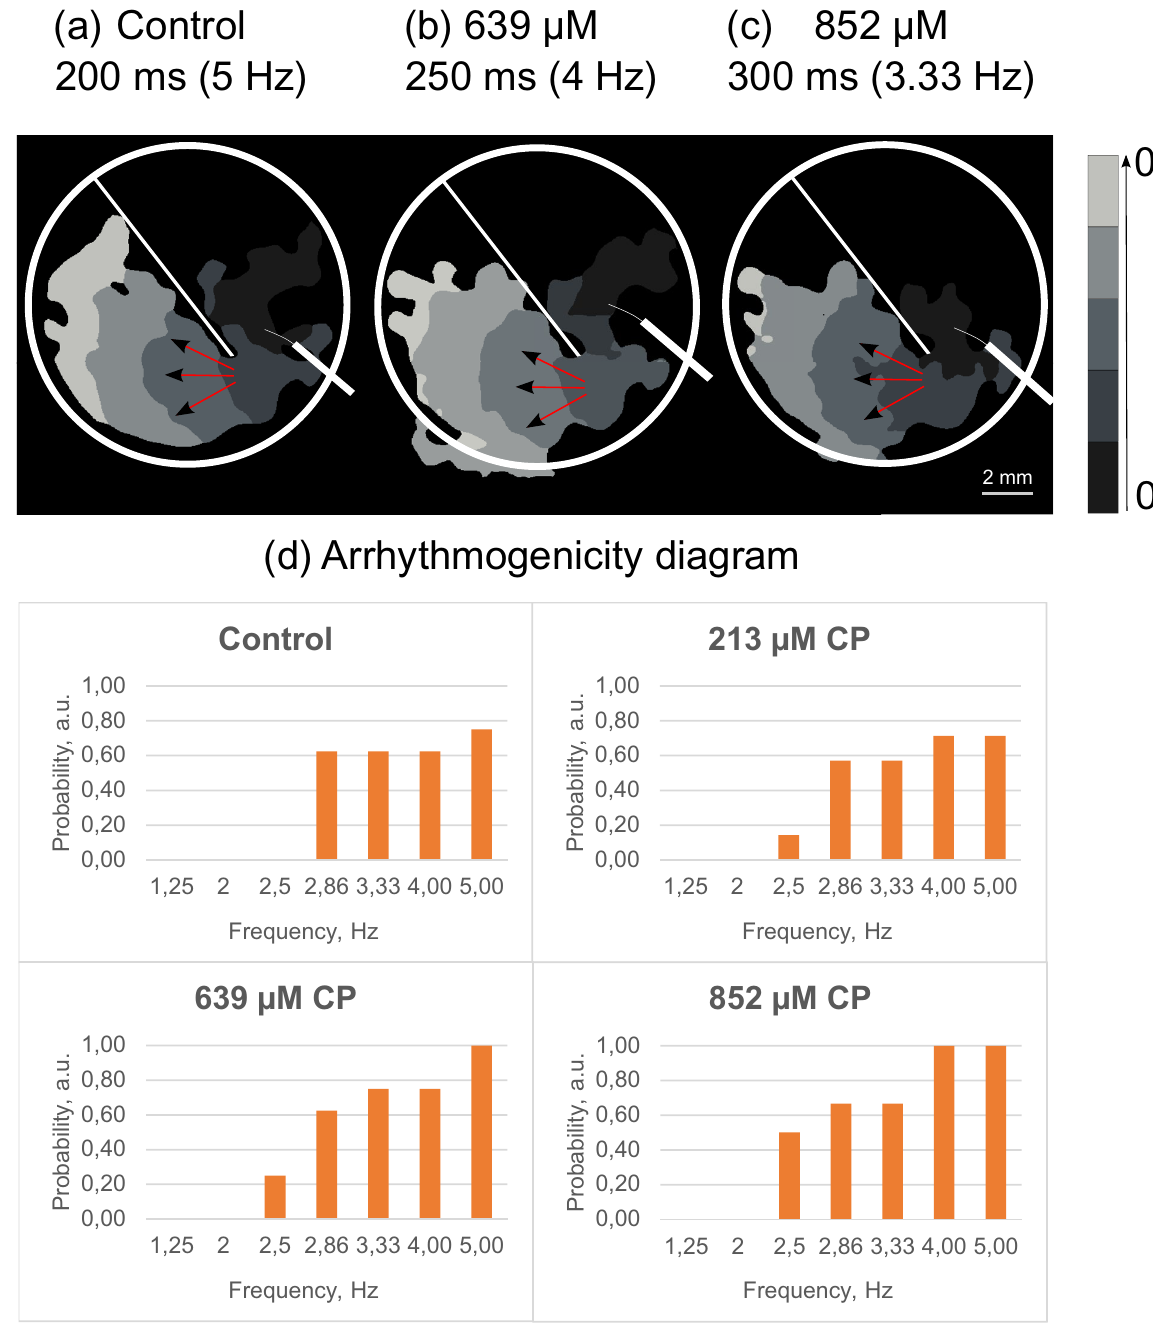
Figure 3. The effect of cyclophosphamide on re-entry formation in the hiPSC cardiac tissue. Activation maps of successful propagation on a standard linear obstacle in ( a ) control, ( b ) under 639 µM (~ 13 mg/kg) and ( c ) 852 µM (~ 18 mg/kg) of CP. The activation time is color coded. The frequency was increased from 1 to 5 Hz in increments of ≤ 0.5 Hz; white circles correspond to the border of the sample, white lines correspond to the location of the obstacle, and red arrows indicate the direction of the excitation wave propagation. Arrhythmogenicity diagram ( d ), the orange bars indicate cases in which the tissue did not capture the external impulses. The vertical values of the diagram bars show the probability of the external impulses non-capturing in the hiPSC-derived cardiac